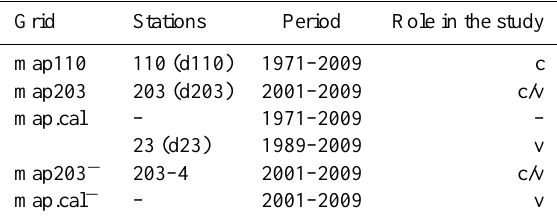
Table 2. Grid, number of stations used to produce grid, available data period and role in the study (c: used for calibration; v: used for validation. Grid Stations